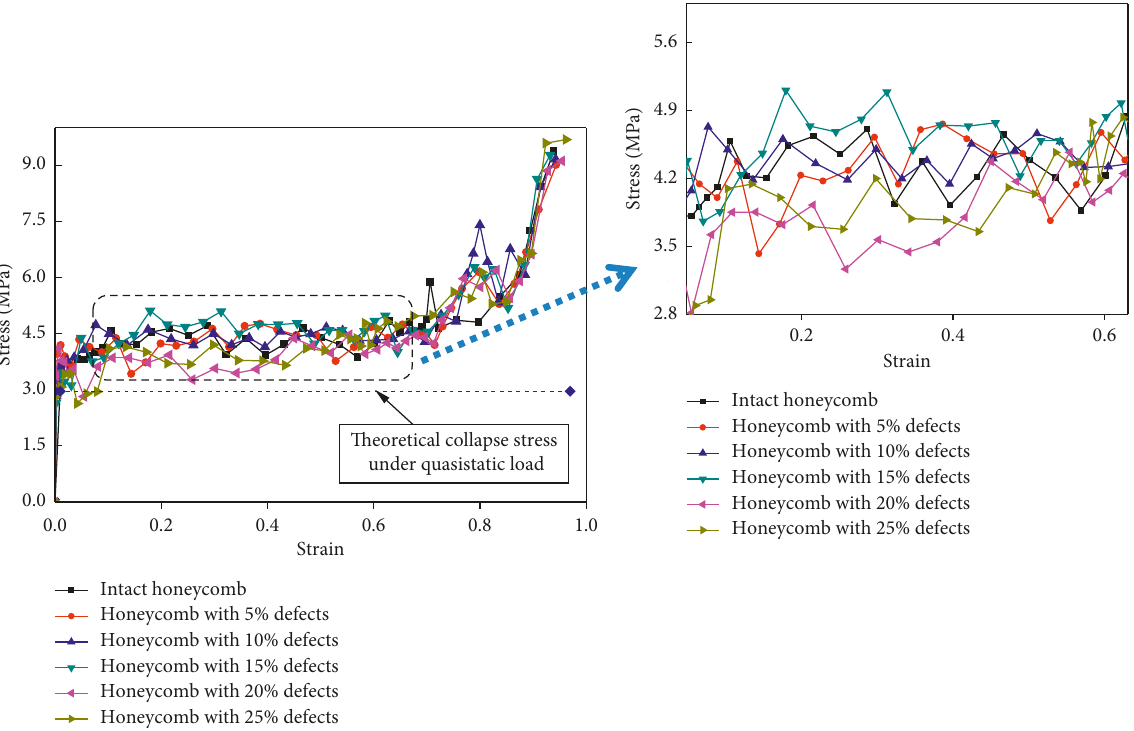
Figure 4: Strain-stress curves of honeycomb material under impact loading.